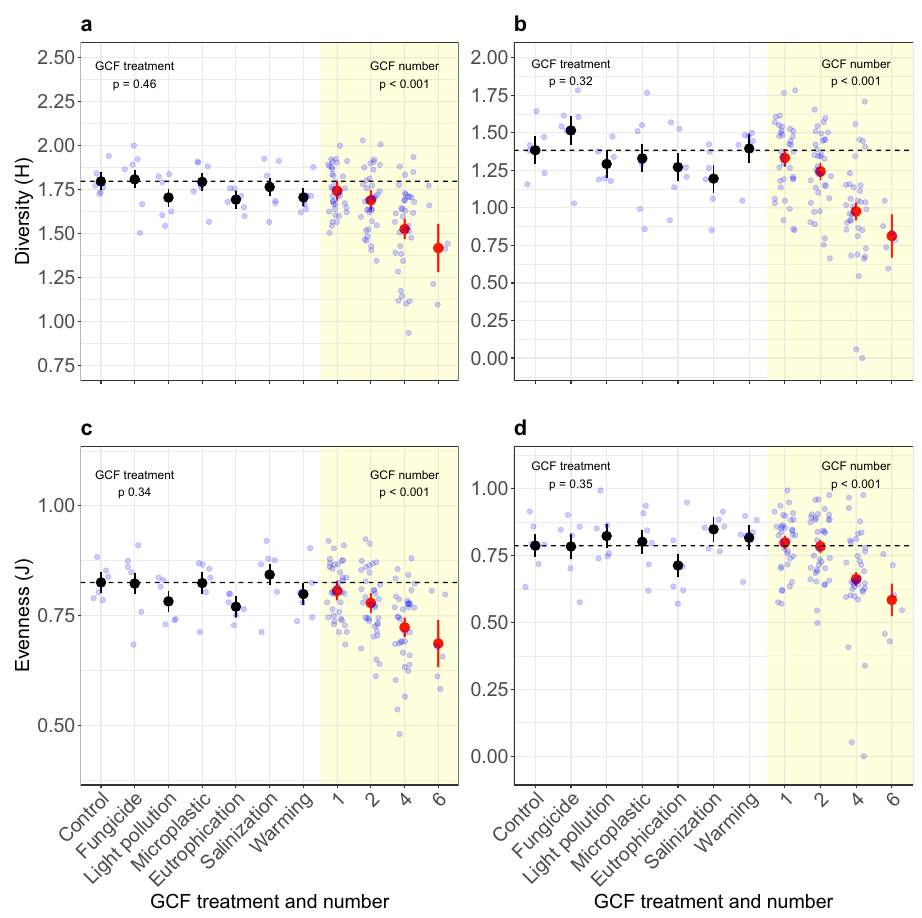
Fig. 3 | Comparison ofsingle-GCF and GCF-number effects on species diversity ofsownandtransplanted-seedlingcommunities. Speciesdiversityandevenness of transplanted-seedling ( a , c ) and sown ( b , d ) grassland communities exposed to different single-GCF treatments (black circles) and to different numbers of simul- taneously acting GCFs (red circles). Species diversity was quanti fi ed as Shannon index( a , b )andasevenness( c , d )basedontheproportionalbiomassofthespecies. In both community types, both species diversity and evenness were signi fi cantly reduced by GCF number while there were no effects of the single-GCF treatments (Supplementary Tables 3 and 4). Black and red circles represent model estimates